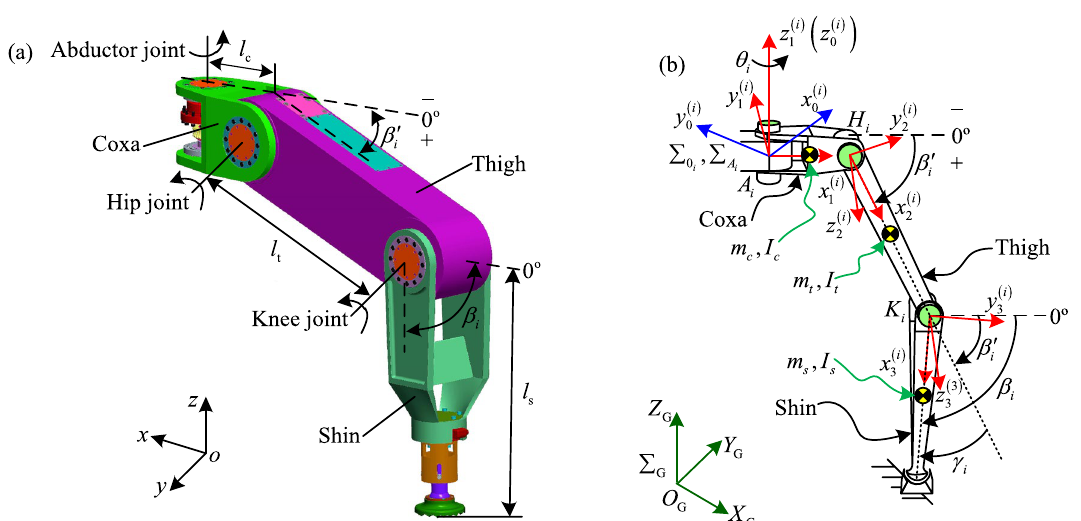
Figure 1 Structure of single leg of large-load-ratio six-legged robot [10, 26, 27]: a Three-dimensional model of single leg, b coordinate systems of joints in single leg